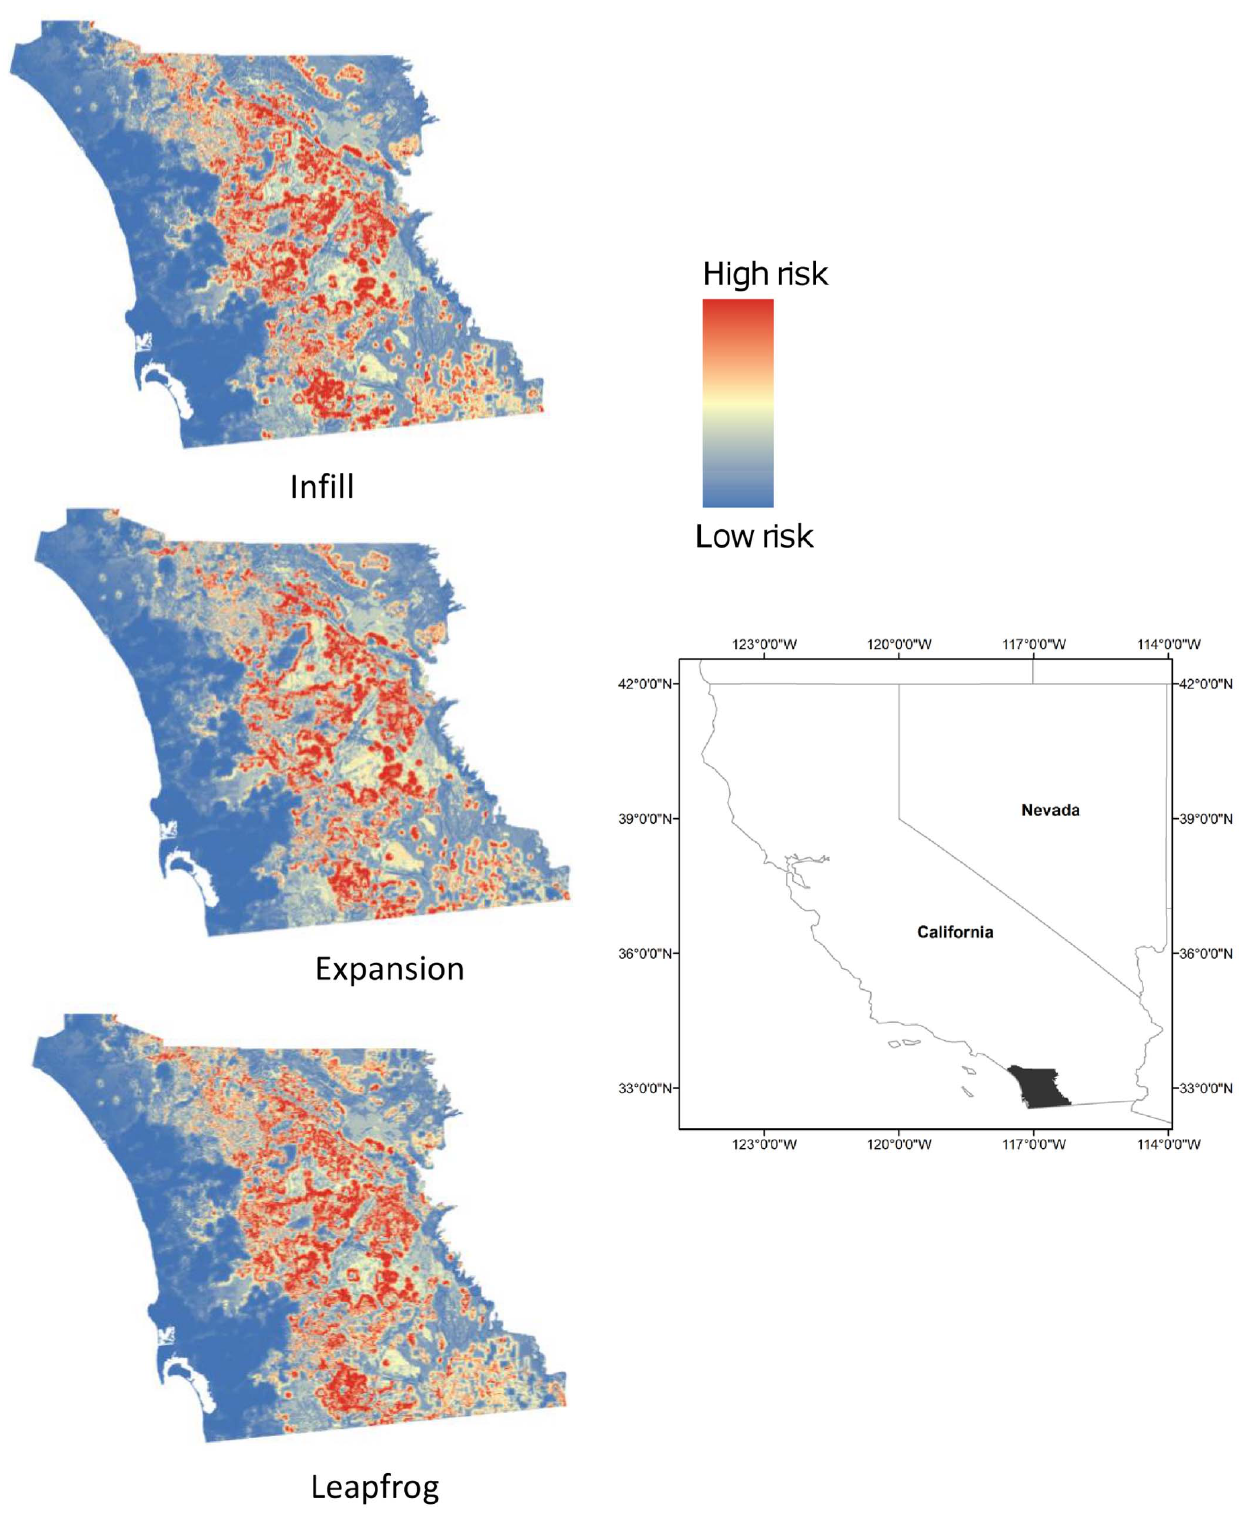
Figure 4. Maps of the study area showing projected wildfire risk at year 2030 for simulations of residential development under policies emphasizing infill, expansion, or leapfrog